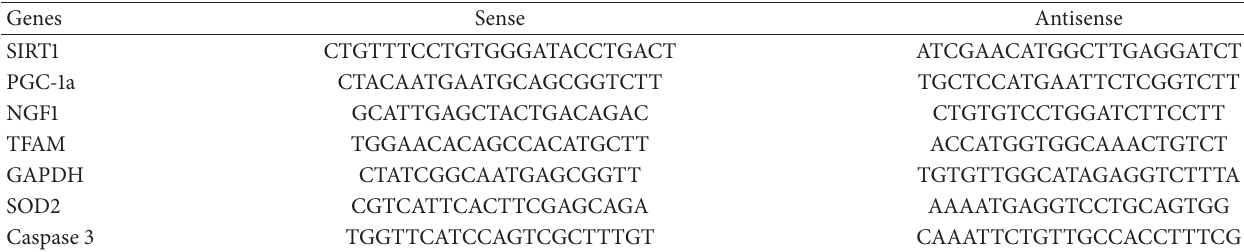
Table 1: Primers used for PCR amplification of cDNA.